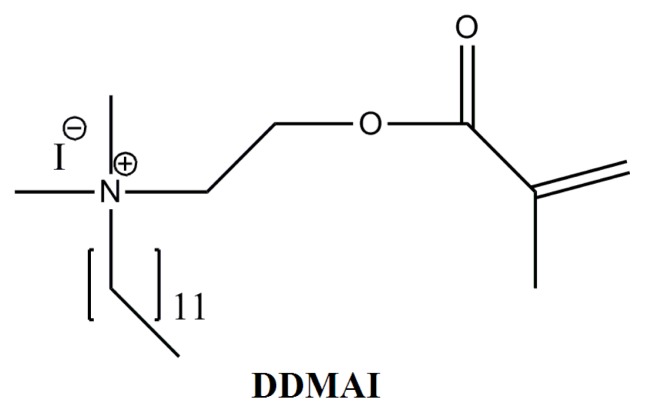
Structure of DDMAI.